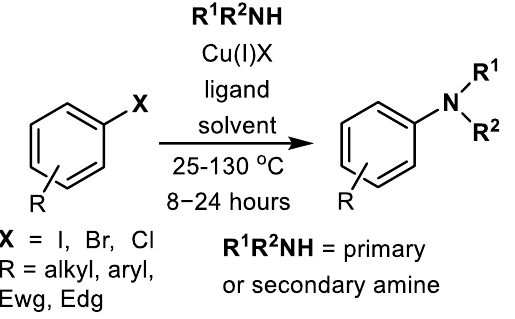
Scheme 10. Arylation of different primary or secondary amines [6 – 10,14 – 28,46,51,54 – 71].